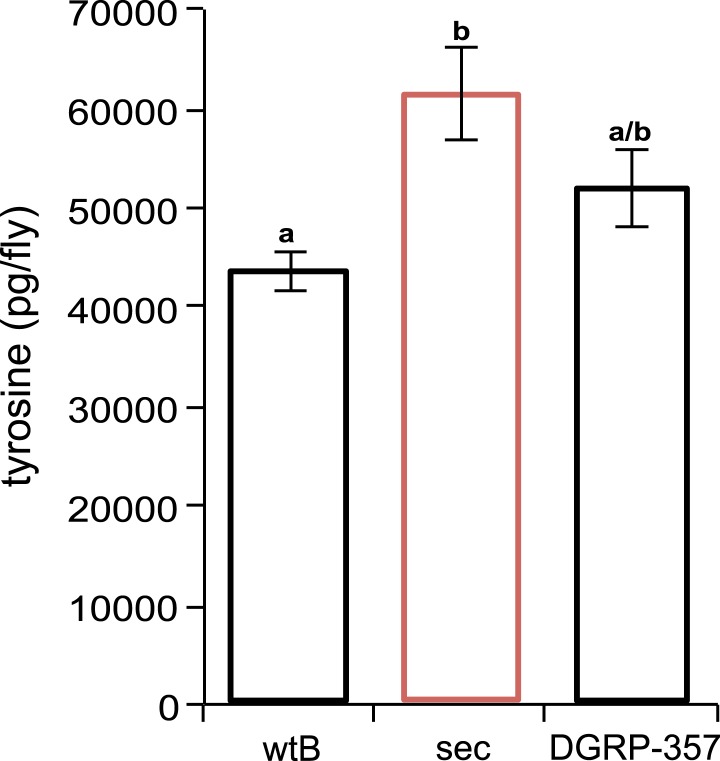
Tyrosine quantification in Drosophila.D. sechellia (14021–0248.25) females (sec) show higher tyrosine content (expressed as picogram per fly [pg/fly]), compared to D. melanogaster wild-type Berlin females (wtB) and D. melanogaster DGRP-357 (DGRP-357) females, fed a standard diet. N = 3. Different letters denote significant differences (p < 0.05) using ANOVA followed by Tukey's test. Error bars represent s.e.m.